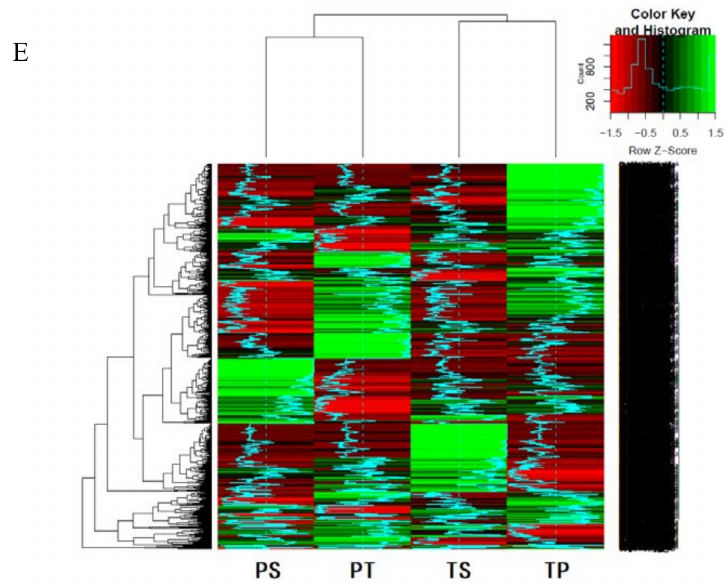
Figure 3. Venn diagram of the number of Differentially Expressed Genes (DEGs) and heat map of the cluster analysis of total DEGs. ( A ) Venn diagram of the number of DEGs between pin and thrum comparisons; ( B ) Distribution of DEGs in different groups, including those specific to the TS vs. TP and PS vs. PT comparisons, those with similar expression patterns in the TS vs. TP and PS vs. PT comparisons, and those with different expression patterns in the TS vs. TP and PS vs. PT comparisons; ( C ) Number of DEGs upregulated and downregulated in the pin and thrum comparisons. “Both” indicates DEGs with similar expression patterns in the TS vs. TP and PS vs. PT comparisons; “PS vs. PT” indicates DEGs specific to the PS vs. PT comparison; and “TS vs. TP” indicates DEGs specific to the TS vs. TP comparison; ( D ) Number of DEGs with different expression patterns in the TS vs. TP and PS vs. PT comparisons. P indicates DEGs upregulated in the PS vs. PT comparison and downregulated in the TS vs. TP comparison; and T indicates DEGs upregulated in the TS vs. TP comparison and downregulated in the PS vs. PT comparison; ( E ) Heat map of the cluster analysis of all 2135 DEGs from the PS vs. PT and TS vs. TP comparisons; each column contains 2135